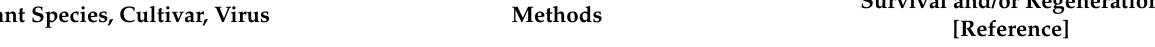
Plant Species, Cultivar,